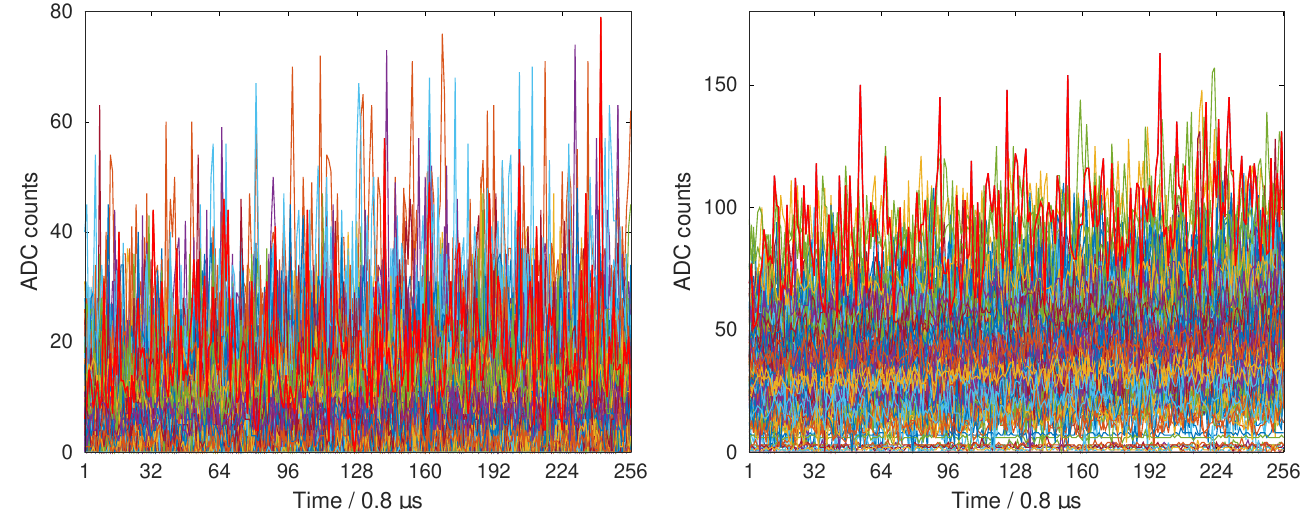
Figure 15. Two examples of events selected by the CNN as slow flashes but not known as such